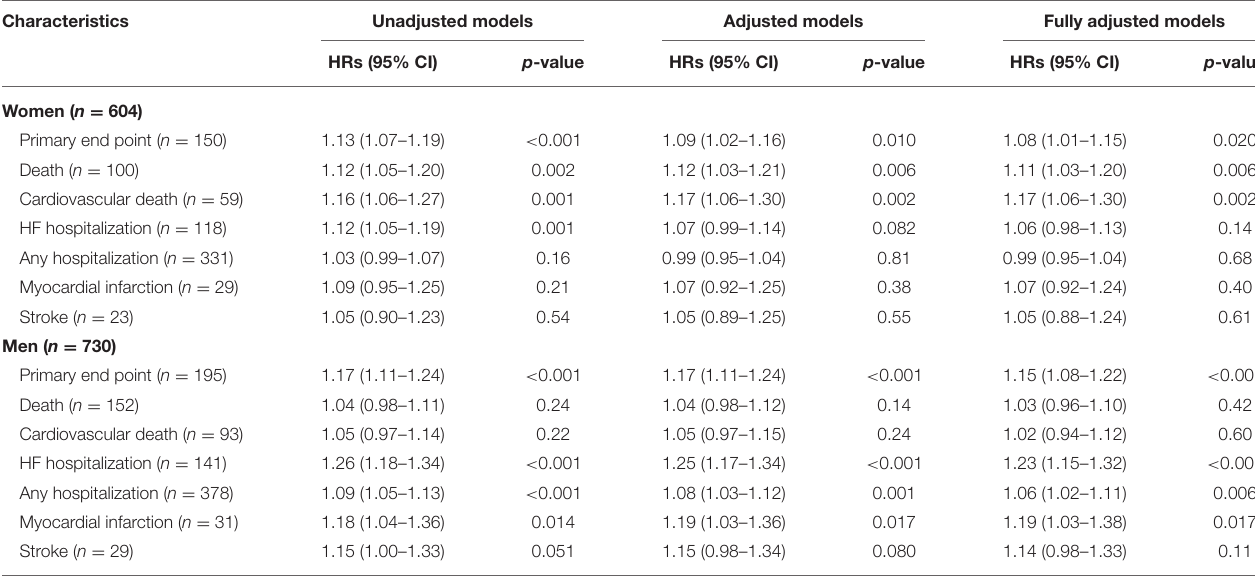
TABLE 4 | Adverse outcomes in relation to the urine microalbumin/creatinine ratio by